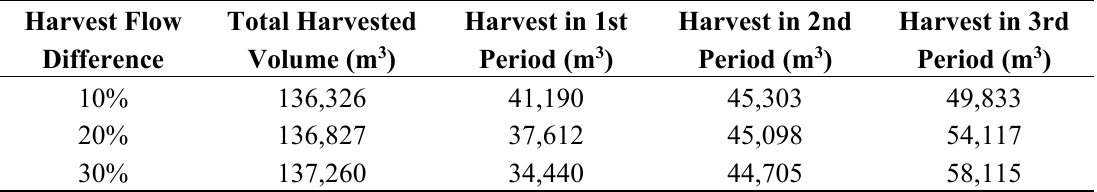
Table 4. The harvest schedule for HfC (harvest-flow constraints) variant for 10%, 20% and 30% harvest flow and 1.00 × 10 −4 gap tolerance.